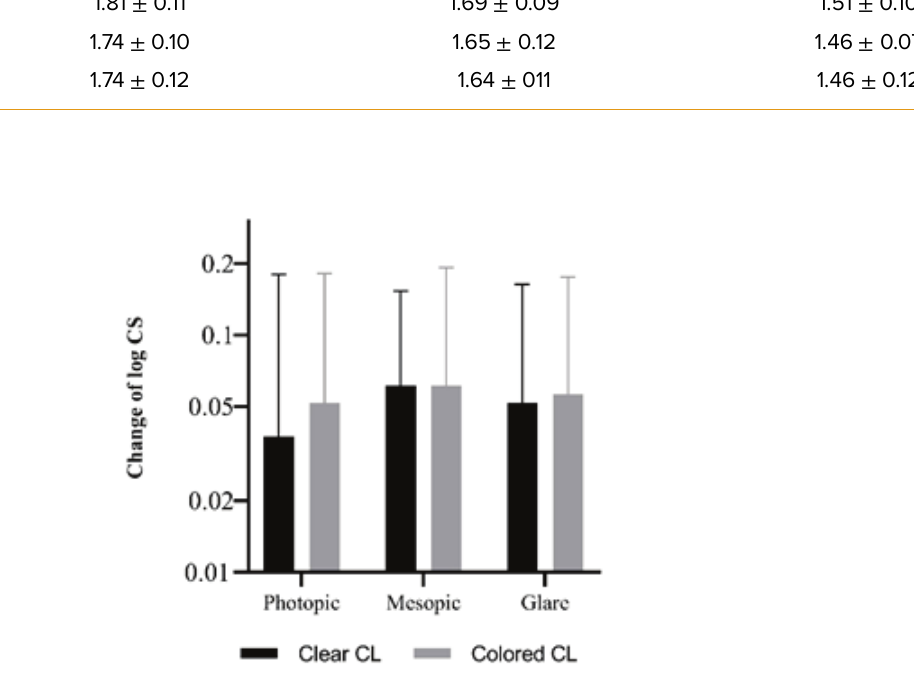
Figure 1. Change in contrast sensitivity (contrast sensitivity without contact lenses minus contrast sensitivity with clear/colored contact lenses) under three lighting